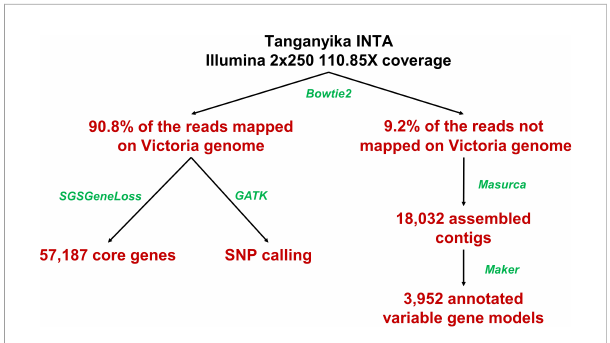
FIGURE 1 Pipeline used to assemble the Eragrostis curvula pangenome. Programs used are highlighted in green and the result in